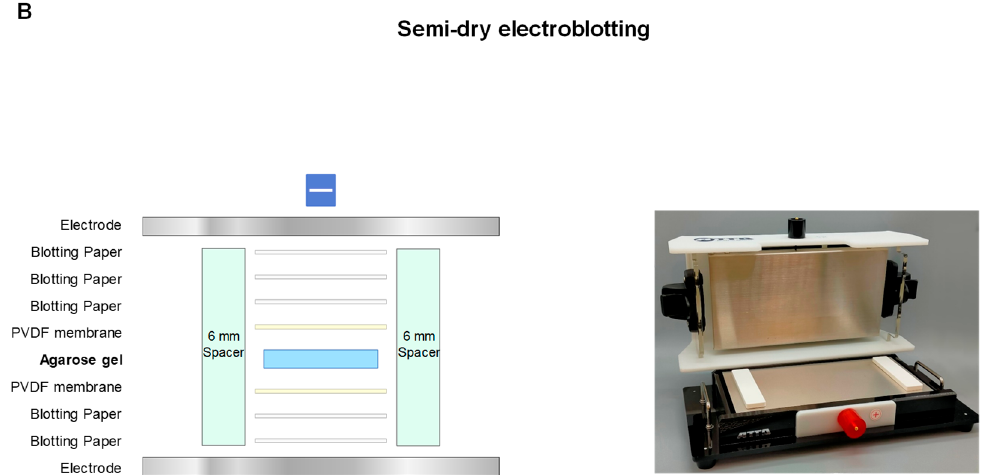
Figure 12. Comparison of blotting method. ( A ) Setup of wet blotting for electroblotting and SDS-electroblotting, where the entire setup is immersed in the transfer buffer. ( B ) Setup of semi-dry blotting for electroblotting and SDS-electroblotting, where PVDF membranes and blotting paper are soaked with the transfer buffer and spacers (6 mm) are placed on both sides to reduce the pressure due to the weight of the blotting device lid and thereby minimize protein diffusion before commencing electrotransfer process.